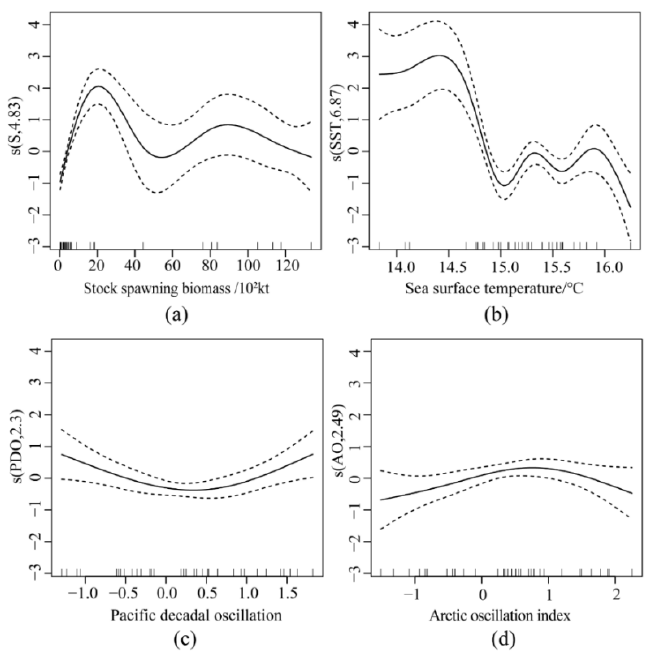
Figure 7. GAM multifactor fitting residual diagram (dashed parts are confidence intervals). ( a ) Residuals of stock spawning biomass; ( b ) Residuals of sea surface temperature; ( c ) Residuals of Pacific decadal oscillation; ( d ) Residuals of Arctic Oscillation Index.